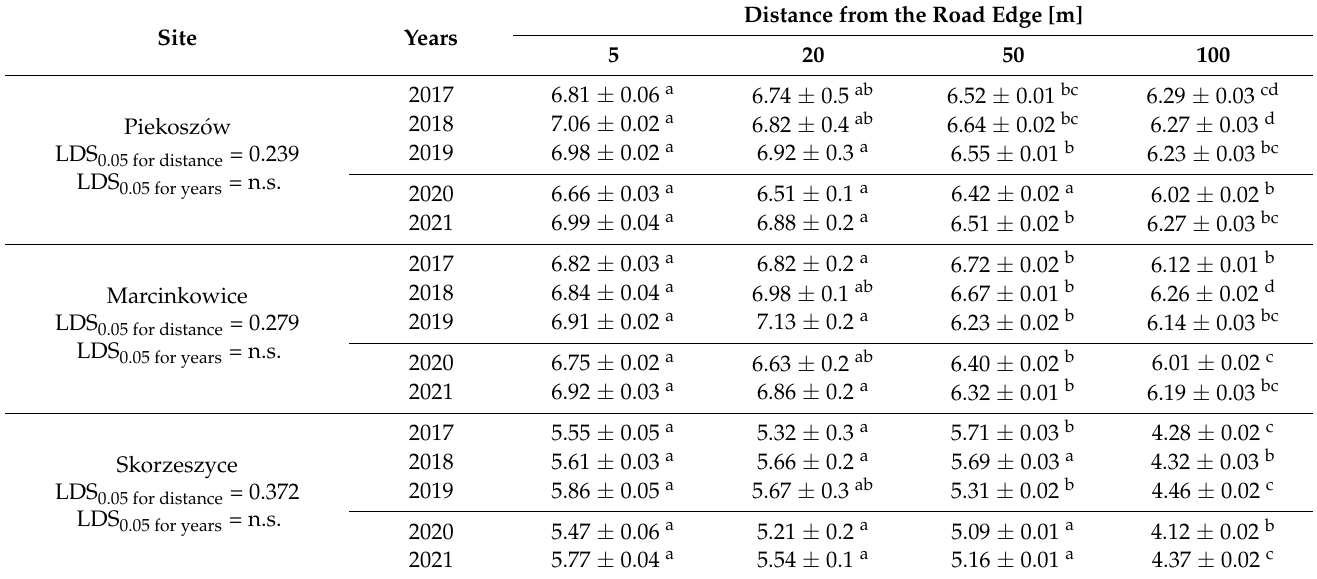
Table 3. The pH KCl values in soils before the COVID-19 pandemic (2017–2019) [28] and during the pandemic